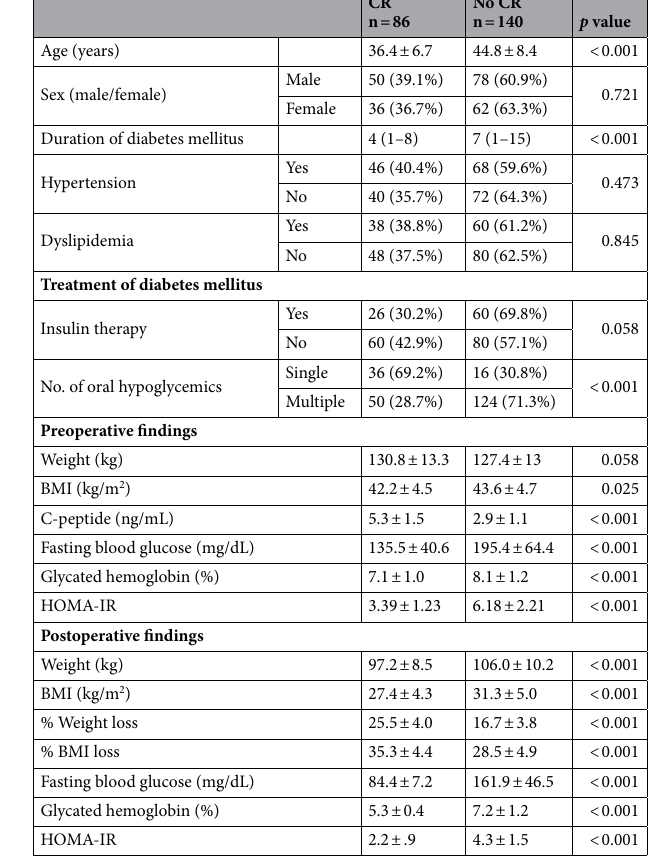
Table 4. Pre- and postoperative characteristics in cases who developed complete remission of T2DM 2 years after LSG and those who did not. CR complete remission, BMI body mass index, HOMA-IR homeostatic model assessment of insulin